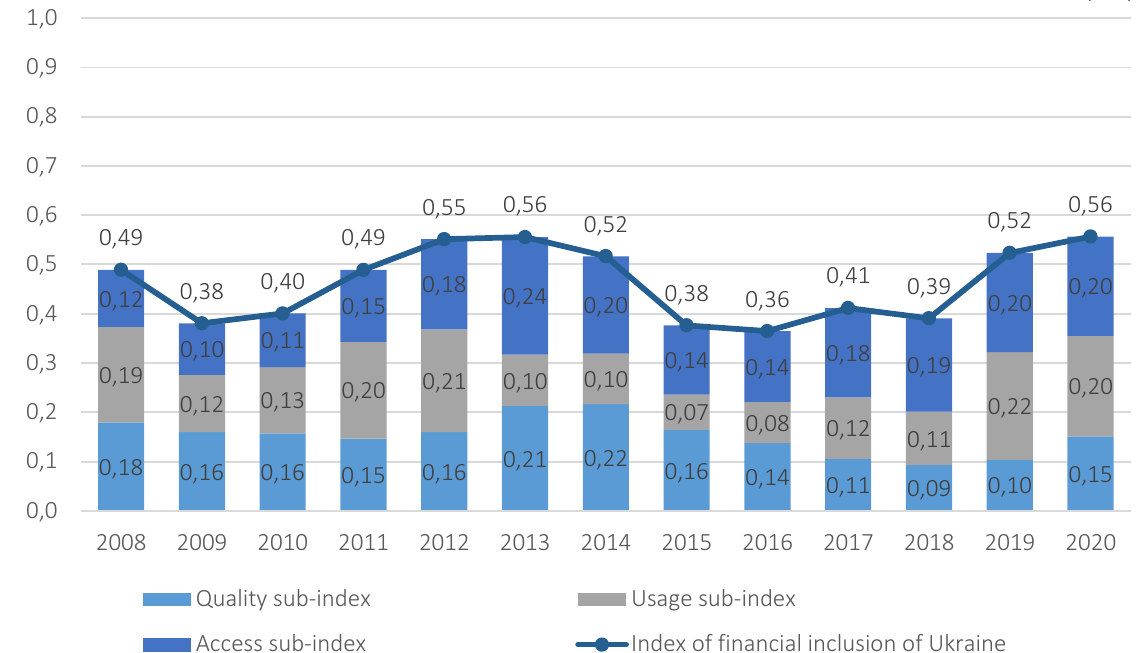
Figure 1. Index of financial inclusion of the Ukrainian economy,